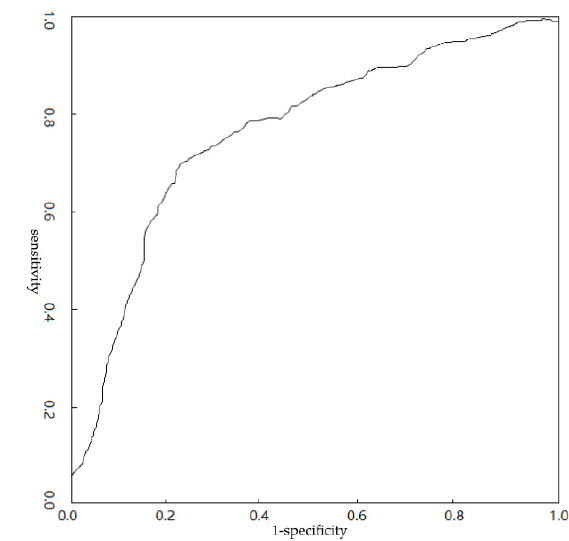
Figure 8. Logistic disease prediction model ROC curve.